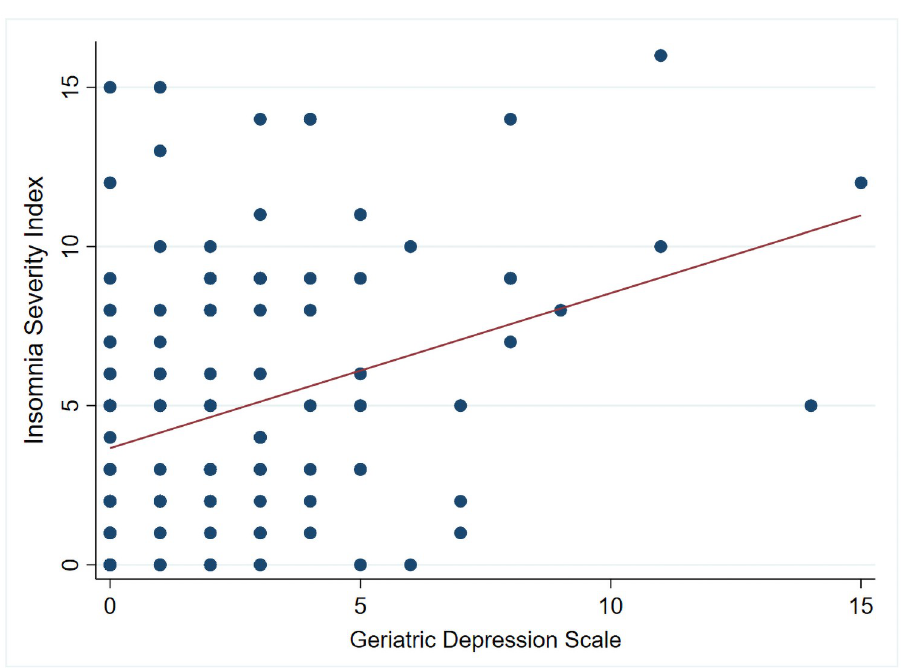
Fig 1. Correlation between Insomnia Severity Index and Geriatric Depression Scale. The figure shows a moderate positive correlation between ISI scores and Geriatric Depression Scale (r = 0.34, P -value < .001) in all participants (n = 119).